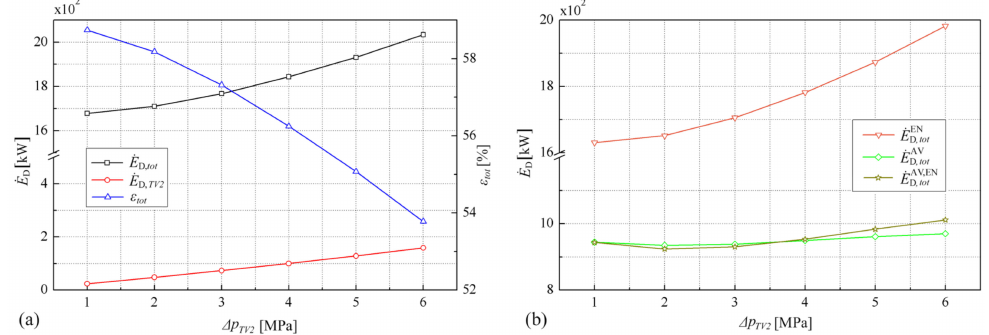
Figure 6. E ff ects of pressure drop in throttle valve 2: ( a ) conventional exergy analysis results; ( b ) advanced exergy analysis results.